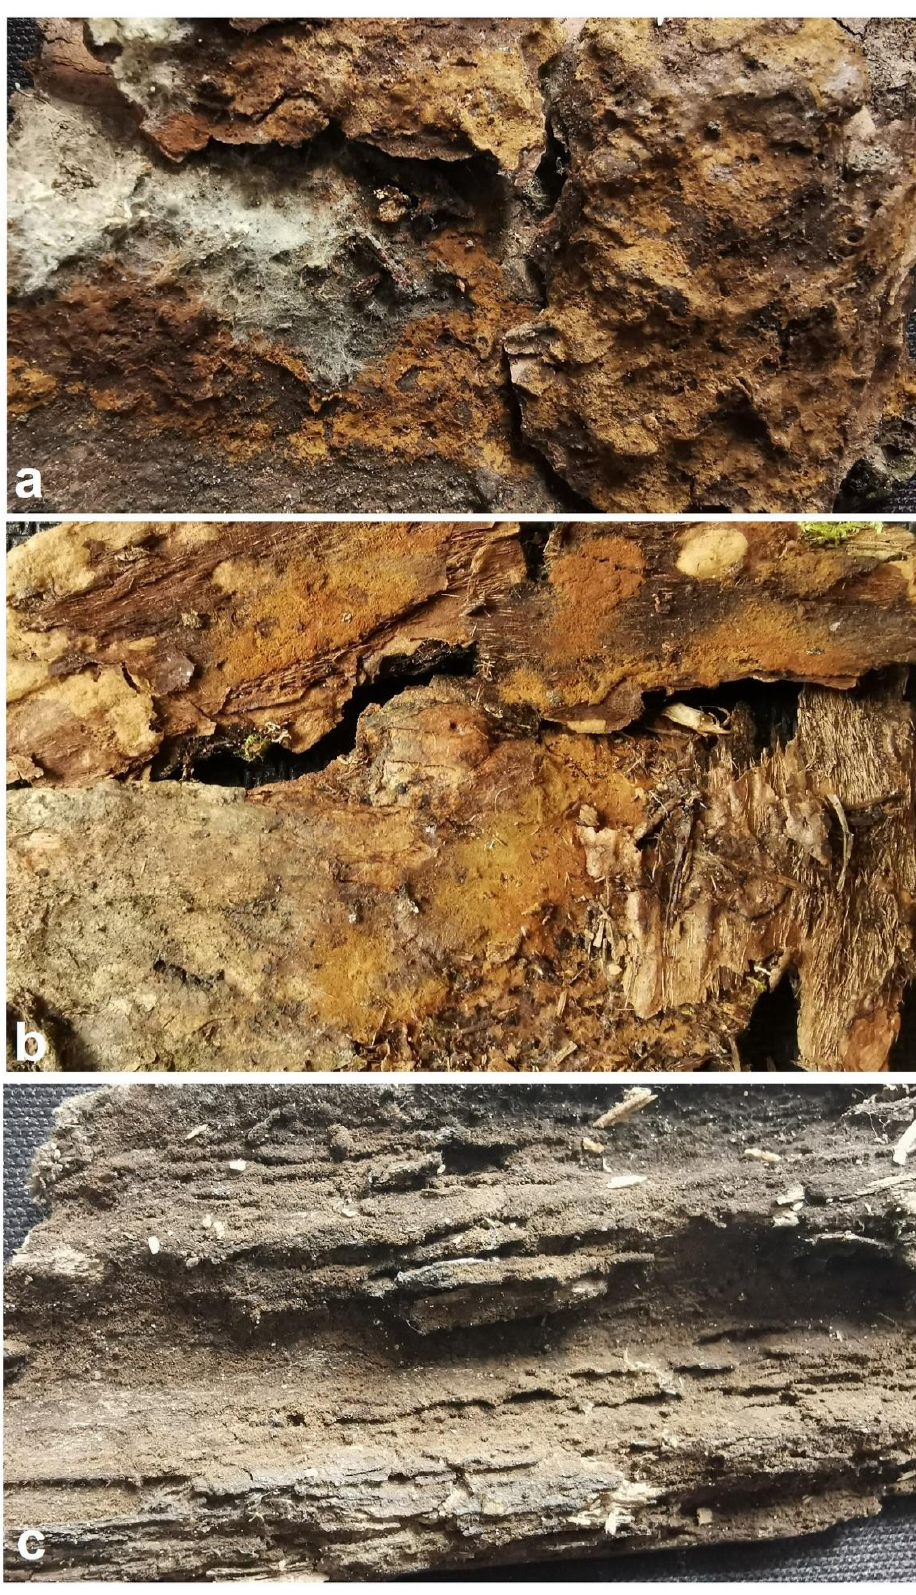
Figure 2. Basidiocarps of Tomentella species. ( a ) T. aurantispora (holotype Yuan 14268); ( b ) T. kanasensis (holotype Yuan 14034); ( c ) T. schrenkiana (holotype Yuan 14262).